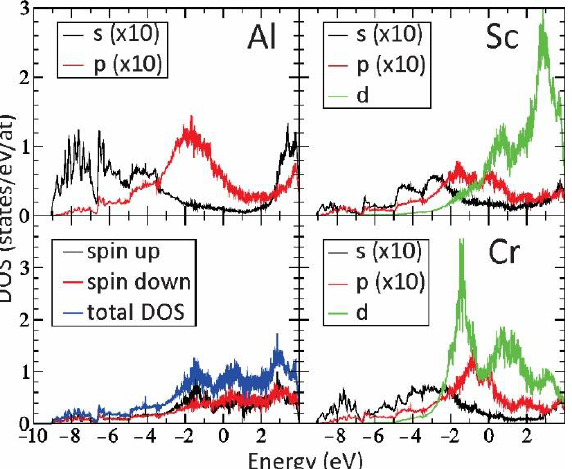
Figure 9. Densities of states (DOS): total DOS (bottom left); Al s and Al p partial DOS (upper left); s, p and d Sc partial DOS (upper right); and s, p and d Cr DOS (bottom right). The Fermi energy is shown on the x-axis while the DOS is shown on the y-axis.